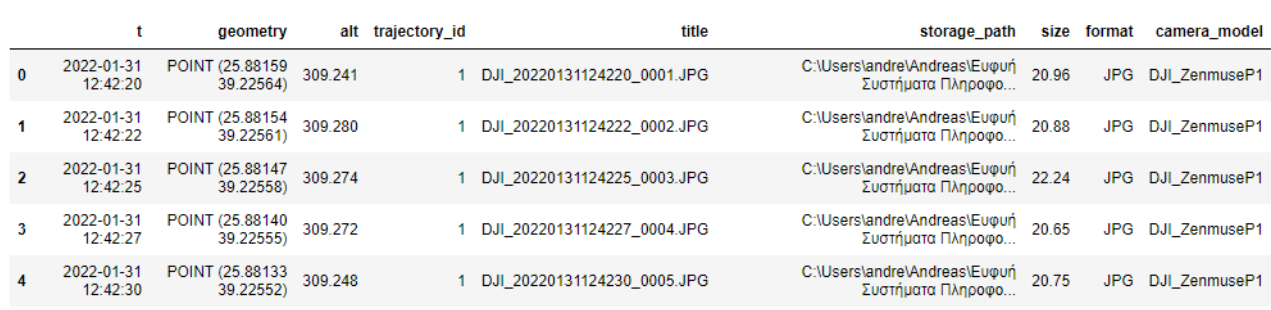
Figure 4. The form of a DataFrame after the trajectory reconstruction process.